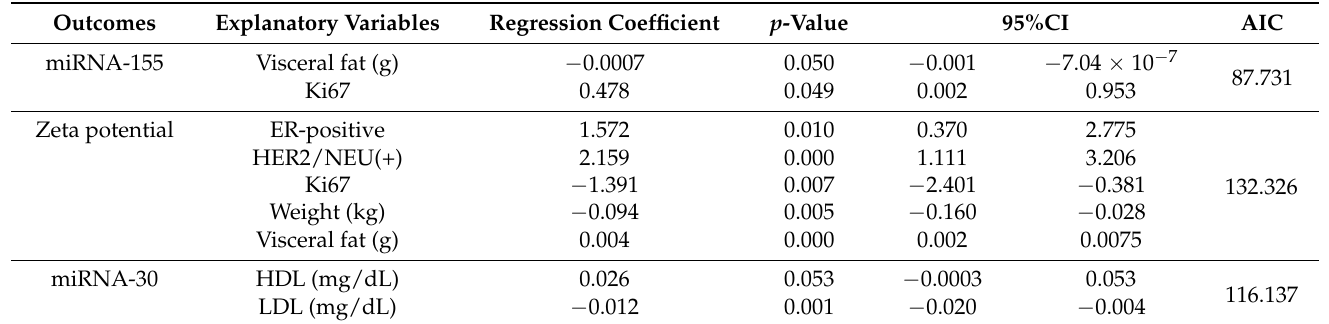
Table 3. Mixed model effects analysis for miRNA-30, miRNA-155 expression, and the Zeta potential in 16 women diagnosed with breast